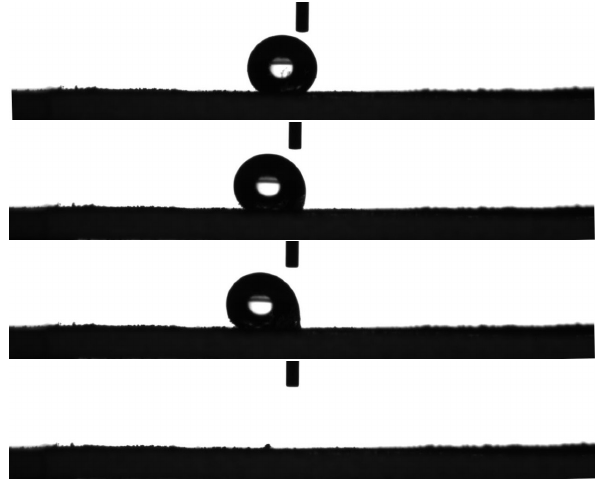
Figure 18: The SA photos of 10ml water-drop on the hybrid coating with 12wt% composite